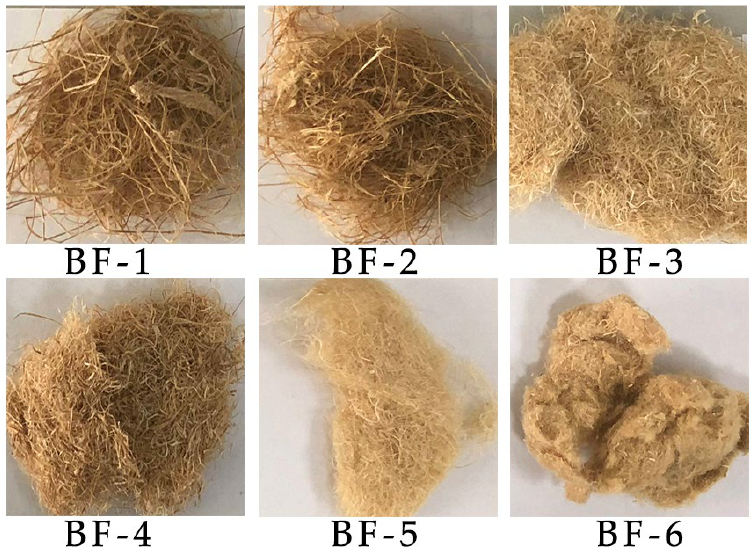
Figure 2. Macroscopic morphology of bamboo fibers with different opening times.